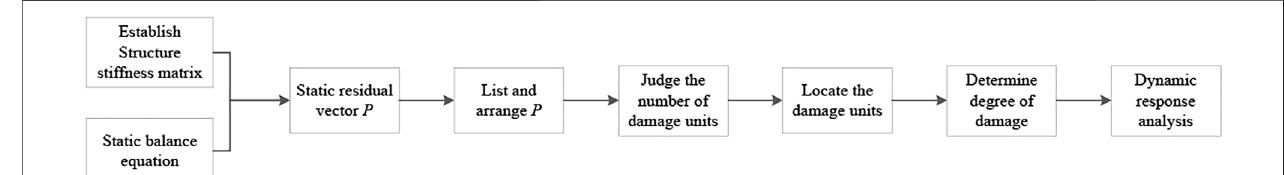
FIGURE 1 | Flow chart of